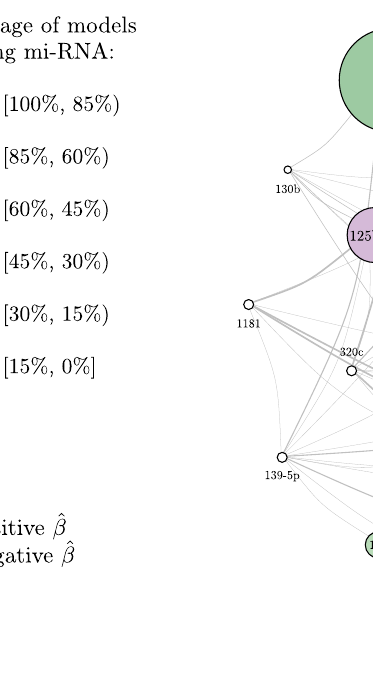
Figure 6. SWAG network of the AHUS dataset. Each node represents an miRNA which appears in a given model at least once. The colour of the node reflects the sign of the median of the estimated β coefficients (i.e. the median of the different values that a miRNA specific β coefficient takes in each of the SWAG models in which it is present). The size of each node is proportional to the percentage of models that contain that specific miRNA among all the 112 SWAG models. The thickness of each link between different nodes (i.e. miRNAs) is proportional to the percentage of times the two miRNAs appear together among all the 112 models. The colour of the link reflects the value of the estimated Spearman correlation coefficient ˆ ρ between two different miRNAs (blue for positive correlation and red for negative).